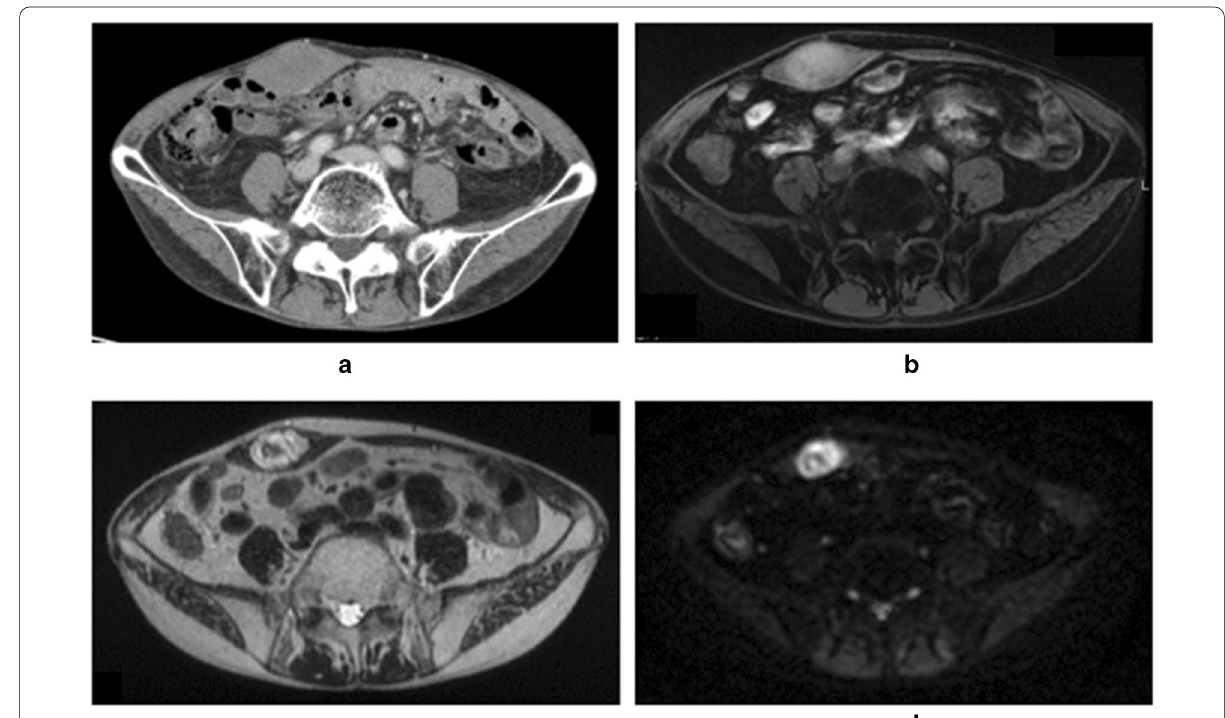
Fig. 1 Abdominal CT scan reveals a tumor measuring 45 mm in a diameter at port site in right abdominal wall after 19 months later from the rectal cancer operation ( a ). Abdominal MRI, the mass was hypo-intense to muscle on T1 imaging ( b ), and hyper-intense on T2 ( c ). Some restricted diffusion was seen around the lesion ( d